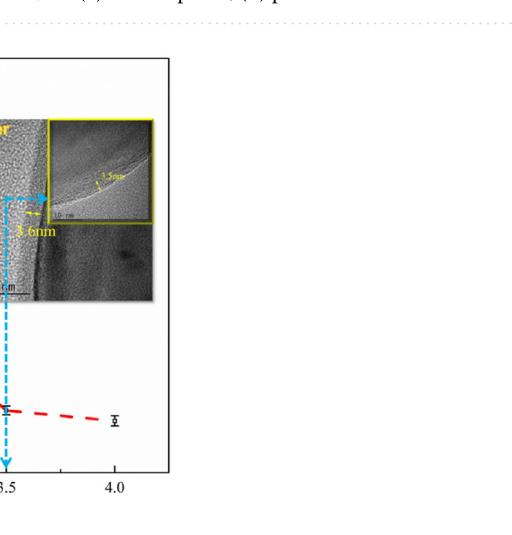
Figure 4. Microstructure characterization of F2311@Al: ( a ) HTEM photo; ( b ) particle size distribution.